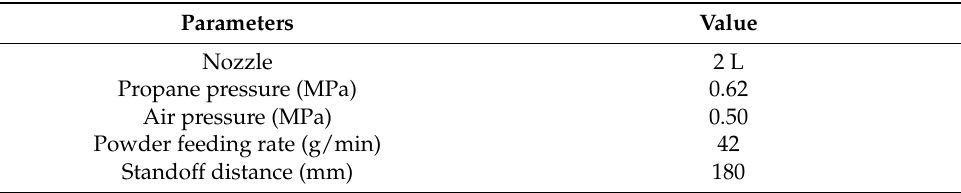
Table 1. Thermal spraying parameters for the HVAF process.